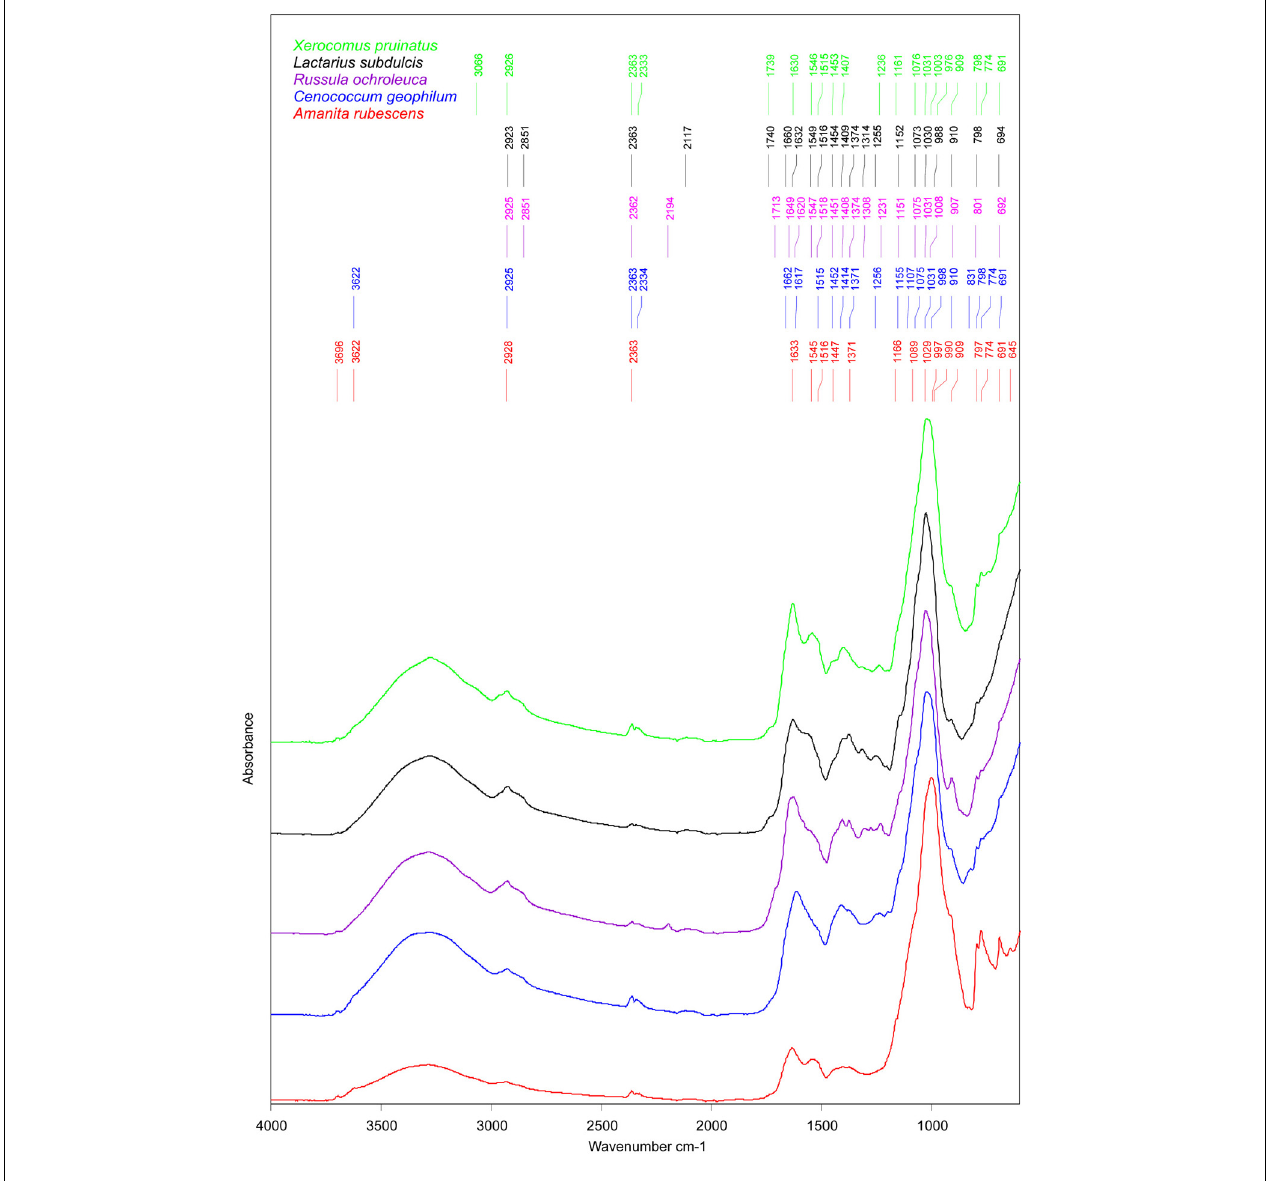
FIGURE 3 | Mean FTIR spectra of field-collected ectomycorrhizas formed with Amanita rubescens ( n = 17), Xerocomus pruinatus ( n = 23), Russula ochroleuca ( n = 13), Lactarius